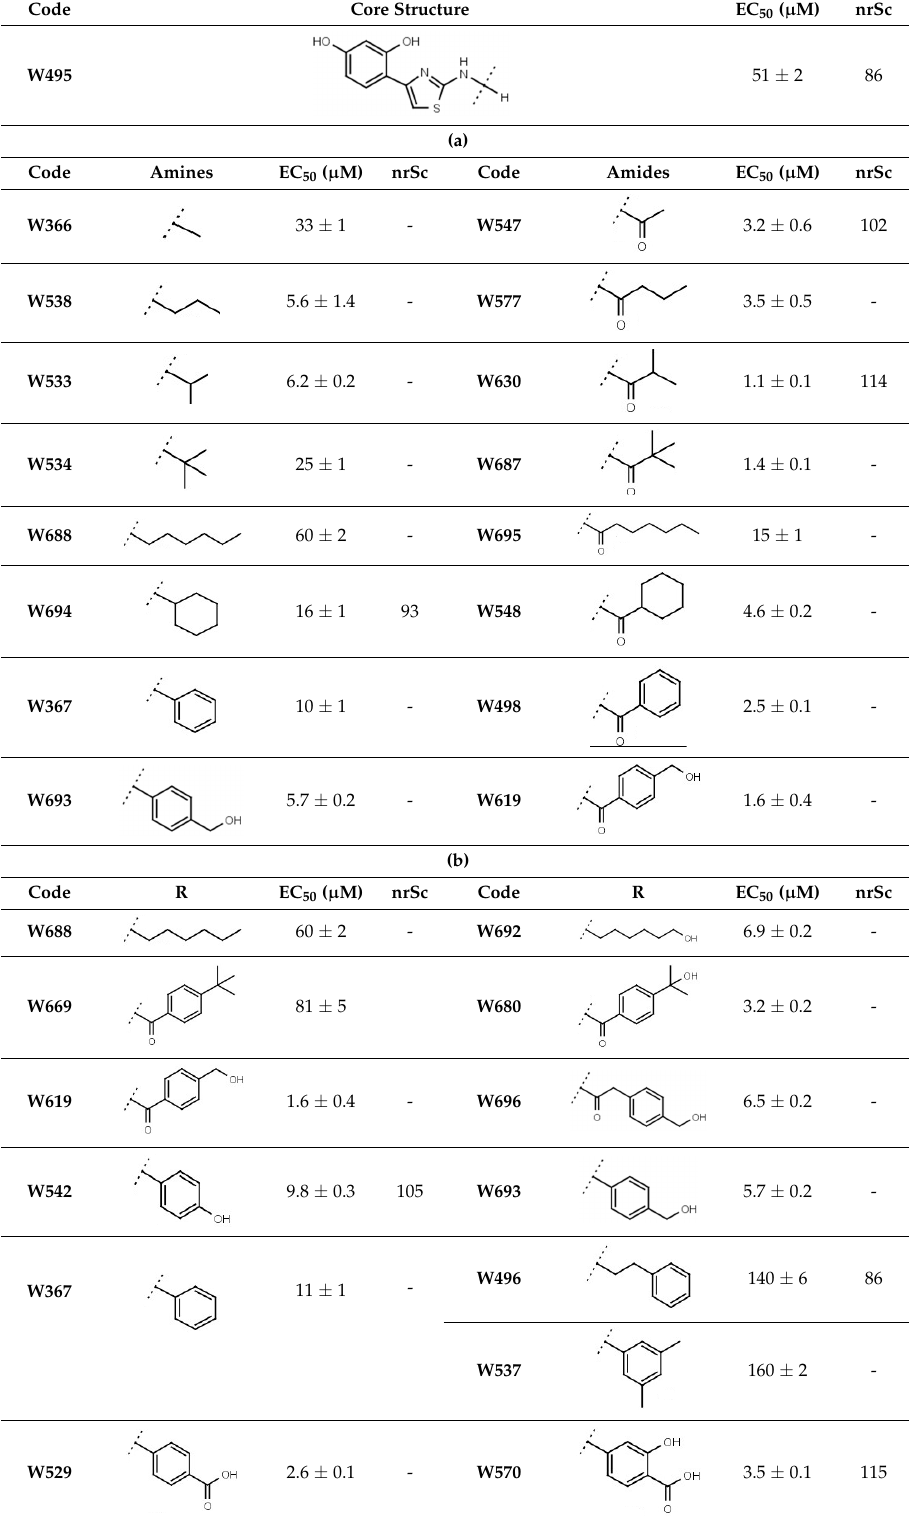
Table 2. Effect of the substituent at the 2-amino group of the thiazole moiety on measured and predicted inhibitory activity in ( a ) amines and amides; ( b ) Influence of size and hydrophobicity of terminal substituents on inhibitory activity. nrSc—negative rerank Score estimated by Molegro Virtual Docker (MVD).